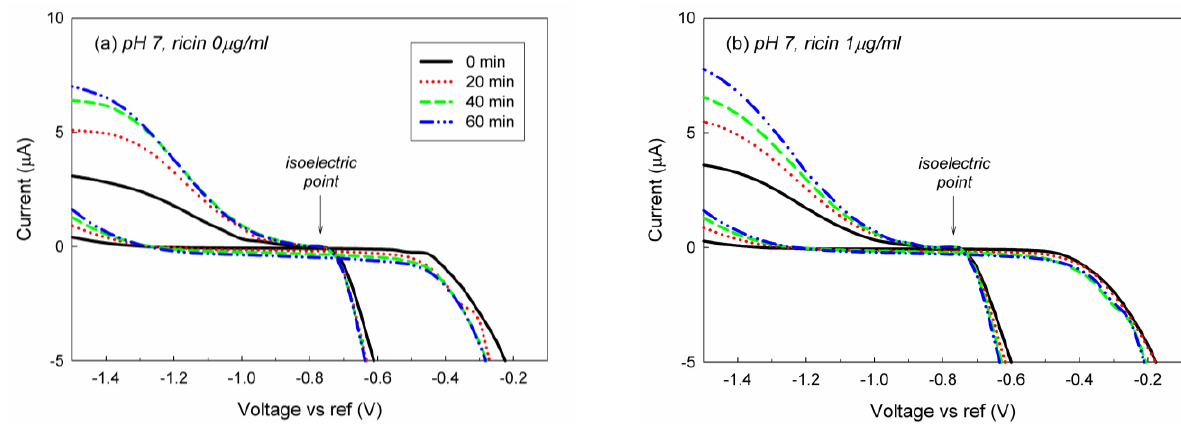
Figure 3. Changes on the cyclic voltammograms of EII at pH 7 in (a) Ag 0 μg/mL and (b) Ag 1 μg/mL. Ricin, the biological toxin, was used as Ag of